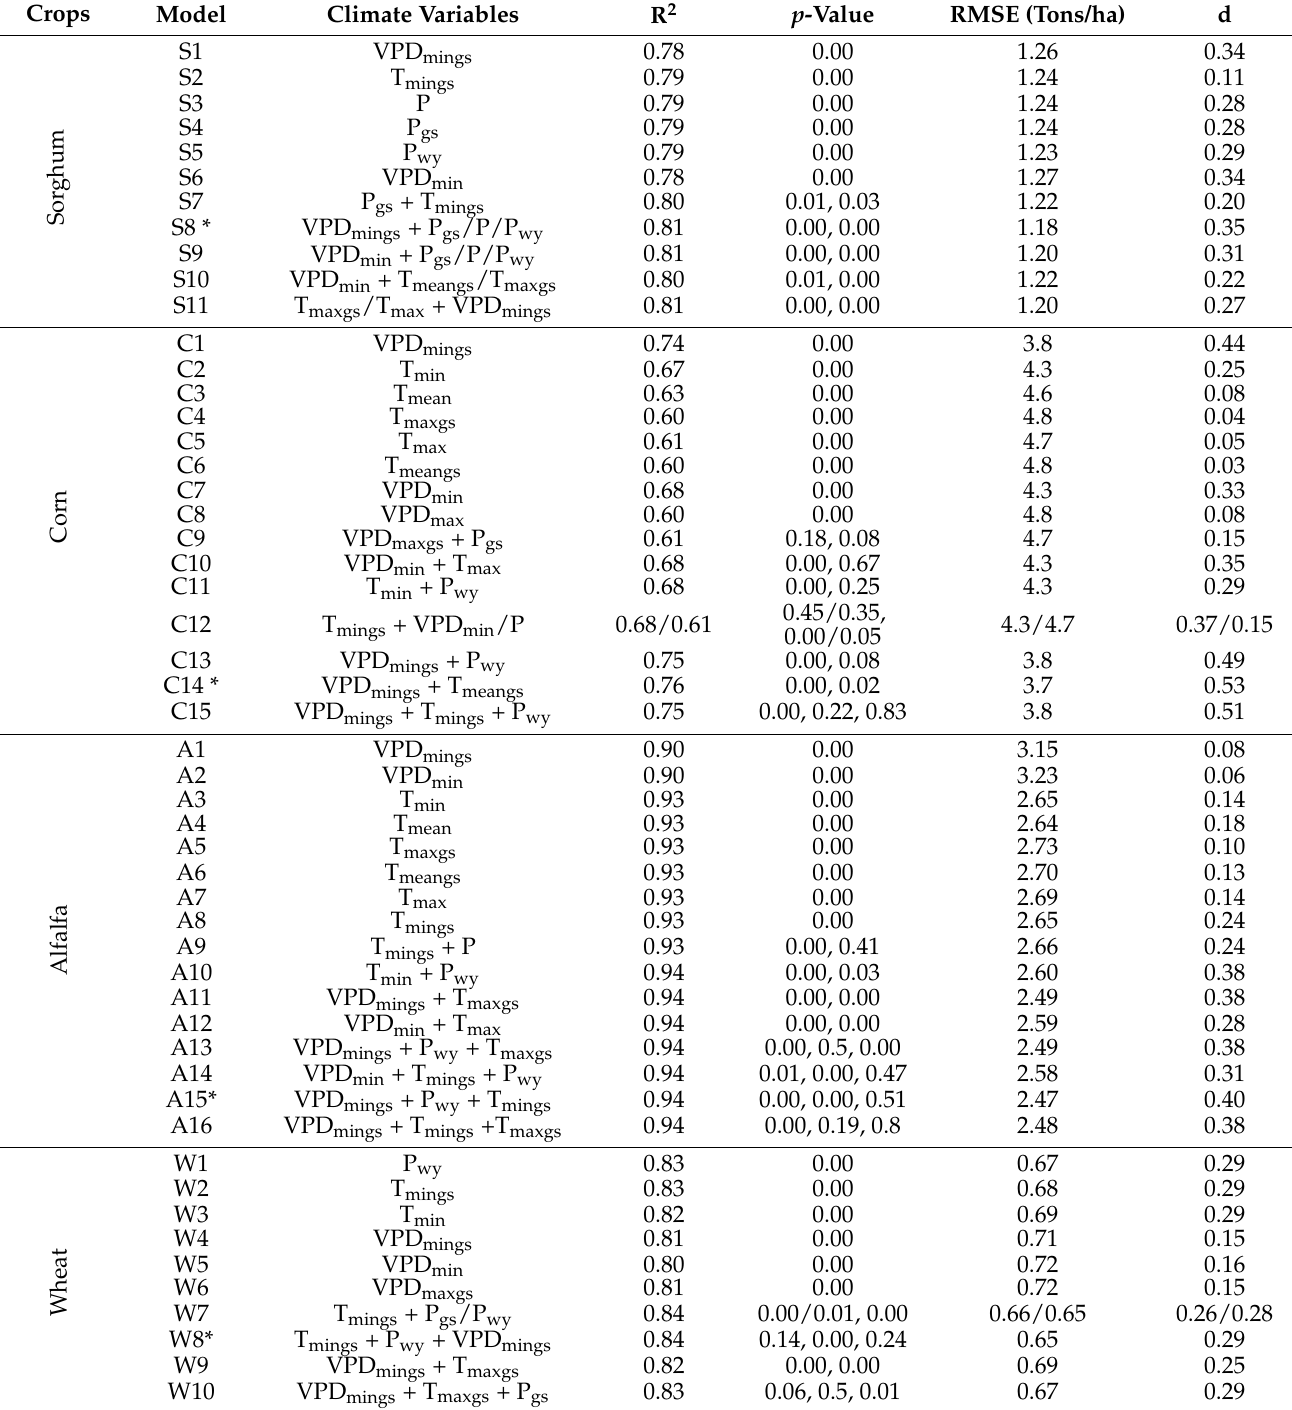
Table A1. The list of multiple linear regression models constructed with climate variables and crop yields of corn, sorghum, alfalfa, and wheat using a time scale of 100 Years (1920–2019).